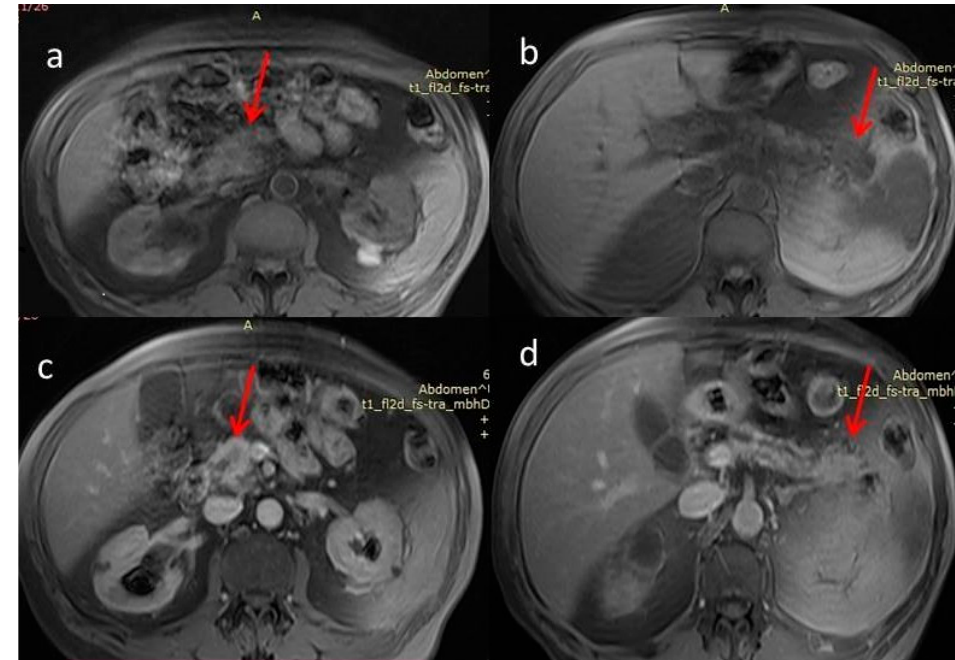
Figure 4. ( a , b ) Magnetic resonance imaging fat-suppressed T1 weighted image (MRI T1WI FS). Hypointense masses. ( c , d ) Magnetic resonance imaging with fat-suppressed post-Gadolinium T1 (MRI T1GD FS). Hypoenhancement of the masses compared to the normal pancreas (red arrows).